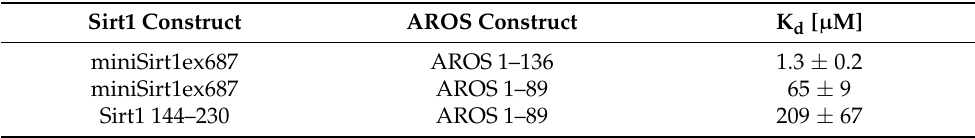
Table 1. K d of Sirt1 interactions with AROS constructs.